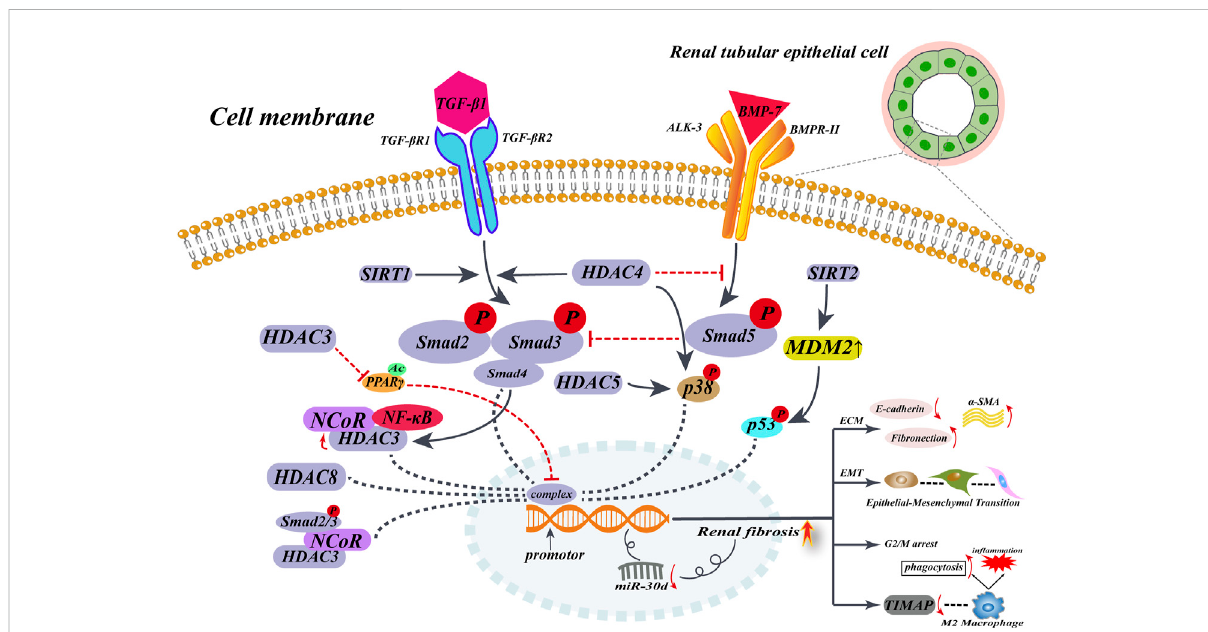
FIGURE 2 HDACs promote renal interstitial fi brosis in non-histone epigenetic modalities of regulation. When renal fi brosis begins, TGF- β expression is upregulated, and elevated TGF- β upregulates HADC expression in renal tubular epithelial cells, in a Smad2/3-dependent way. Then, HDACs translocateintothenucleusbyrecruitingmultiplecytokinestoformcomplexesthatactnearthegenepromoter,mediatingtheexpressionof α -SMA and collagen I. On the other hand, elevated HDACs inhibit the anti- fi brotic factor BMP-7/Smad5 pathway and deregulate the protective factor of BMP-7, ultimately promoting the development of renal fi